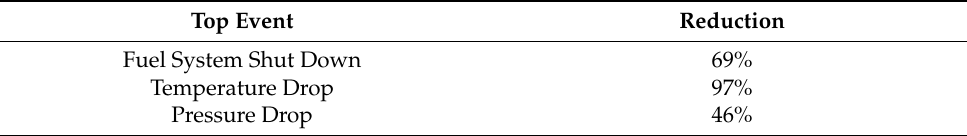
Figure 11. Derived failure rates for the baseline and modified LNG fuel system configurations.